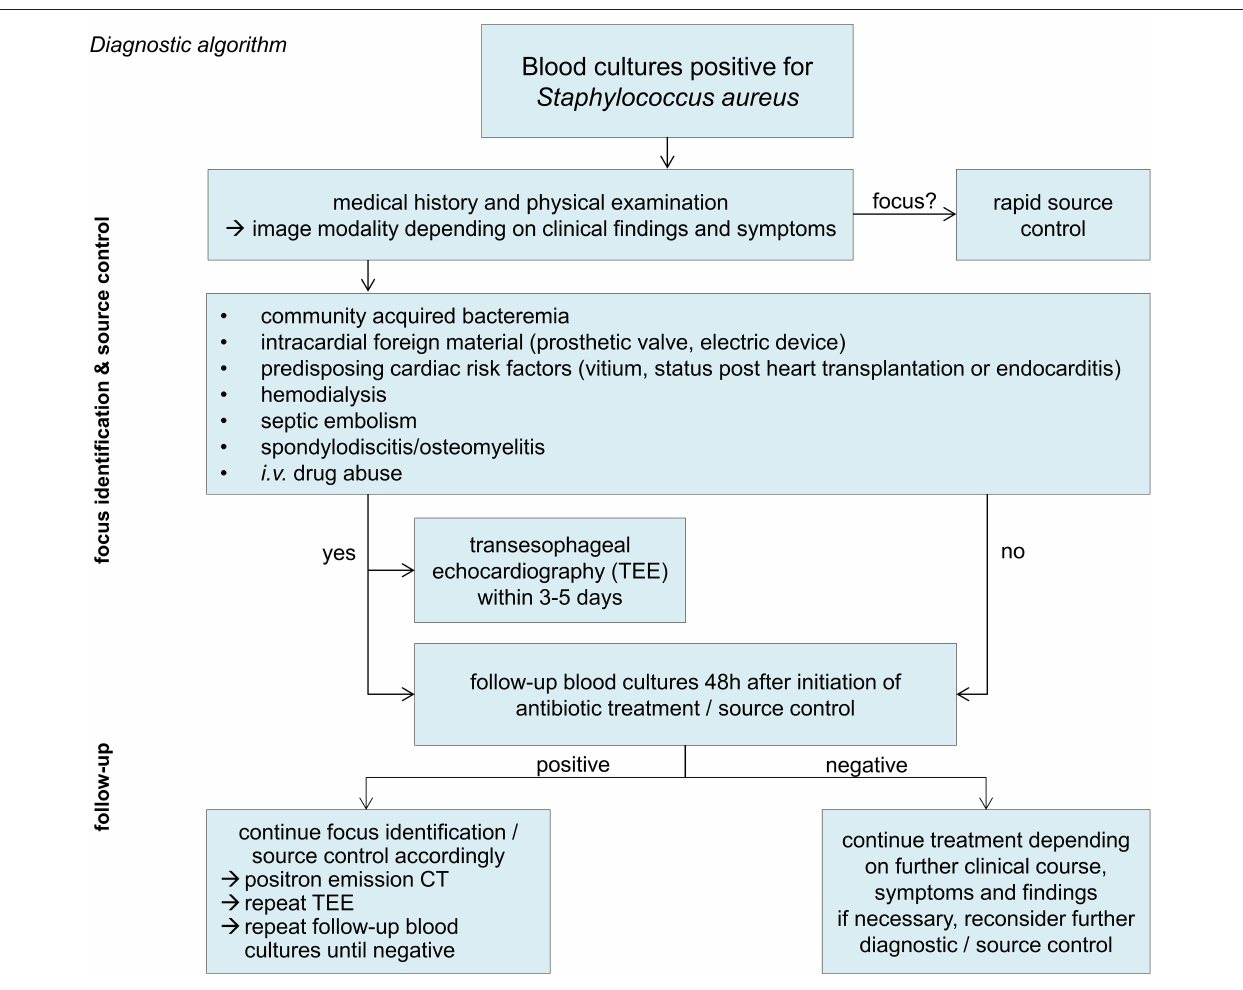
FIGURE 1 | Diagnostic